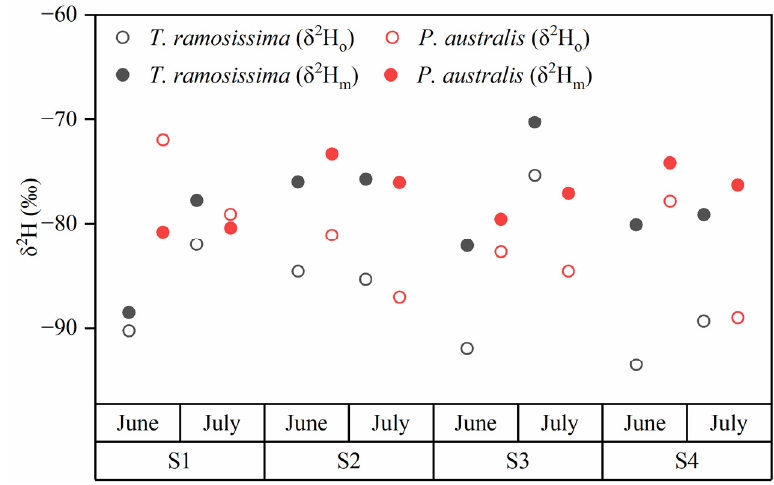
Figure 6. δ 2 H values of plant xylem after PW-excess corrections. δ 2 H o represents the original δ 2 H value measured experimentally, and δ 2 H m represents the δ 2 H value corrected by PW-excess.